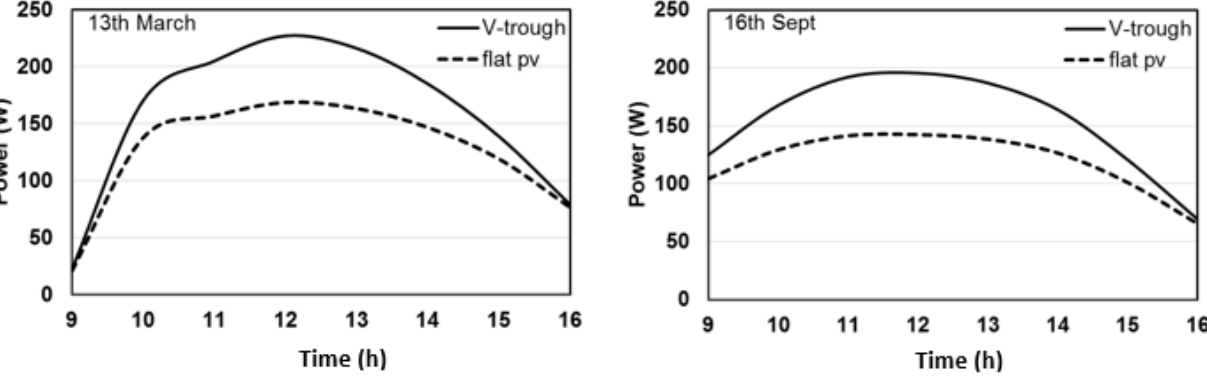
Figure 12. Maximum power output (uncooled).